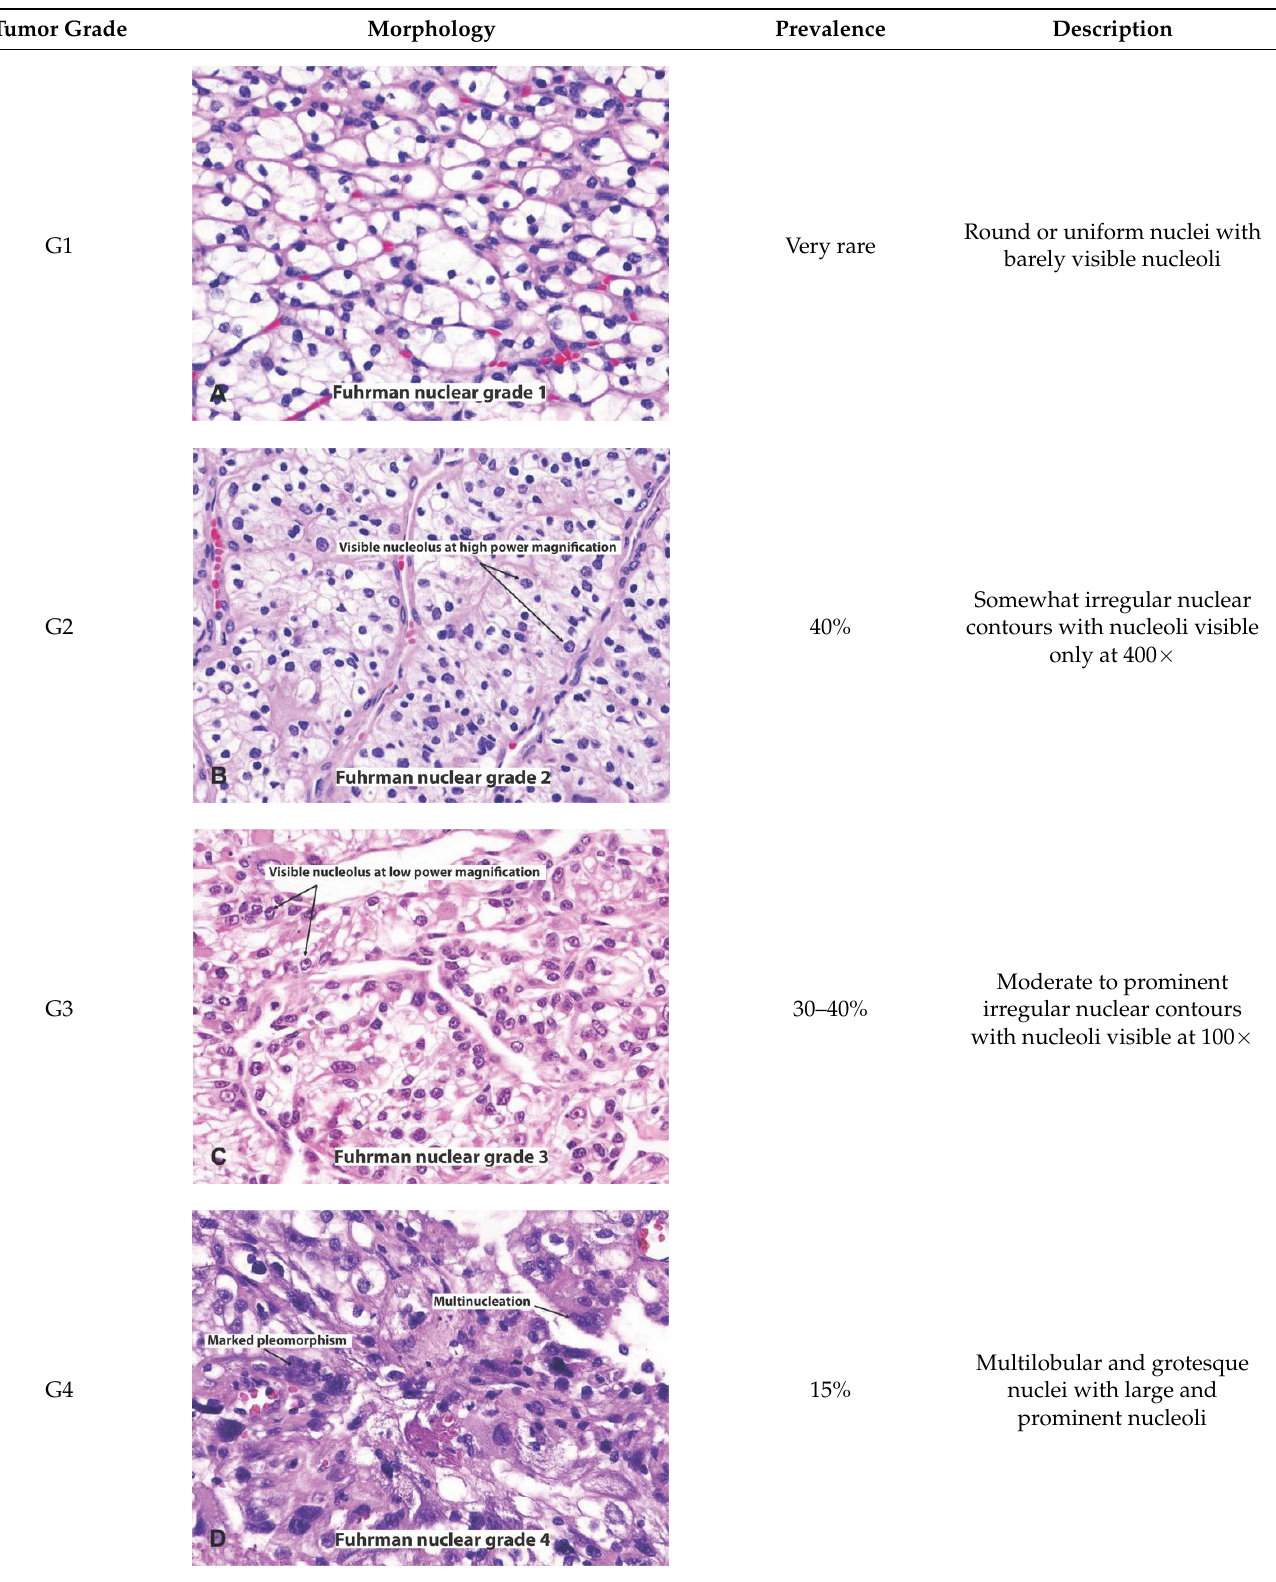
Table 2. Fuhrman nuclear grade classification for RCC tumors.